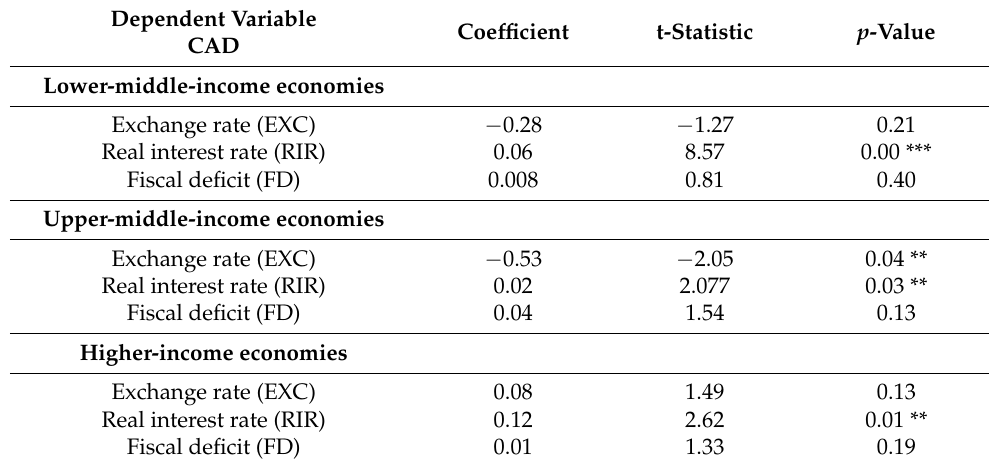
Table 9. Results of panel EGLS (random effects).